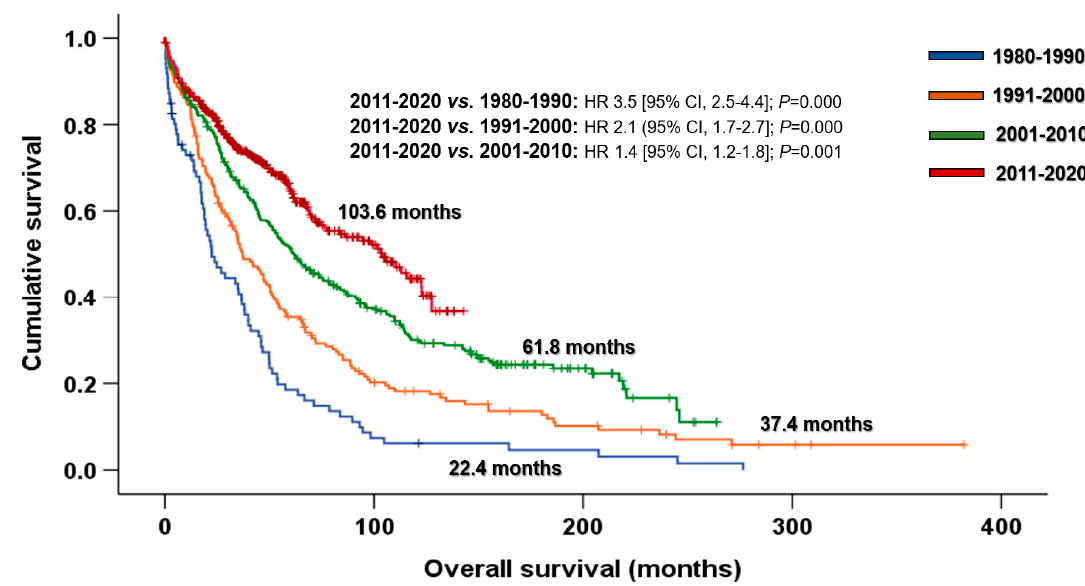
Figure 1. Overall survival by decades. Abbreviations: CI: confidence interval; HR: hazard ratio.